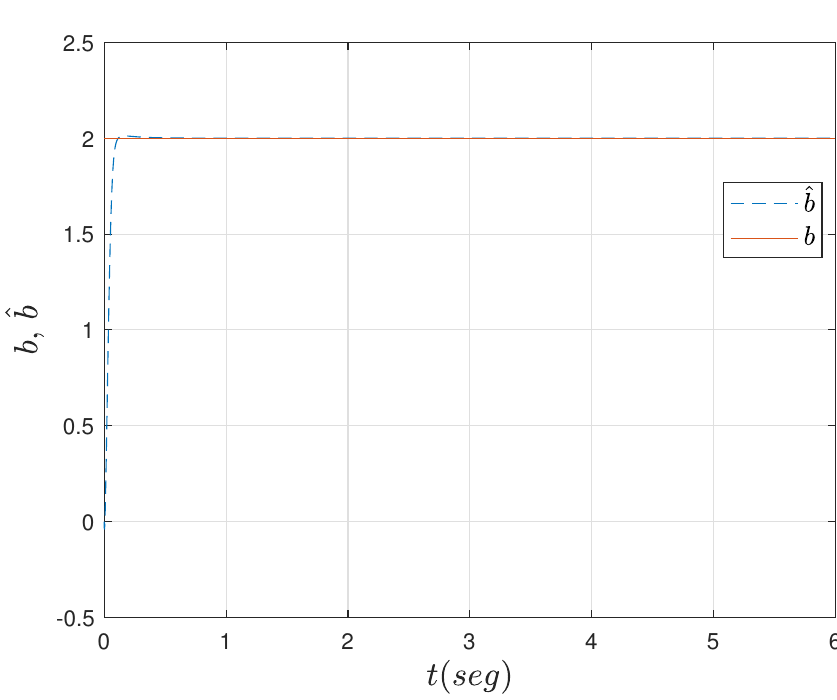
Figure 7. Progression of the convergence for ˆ b